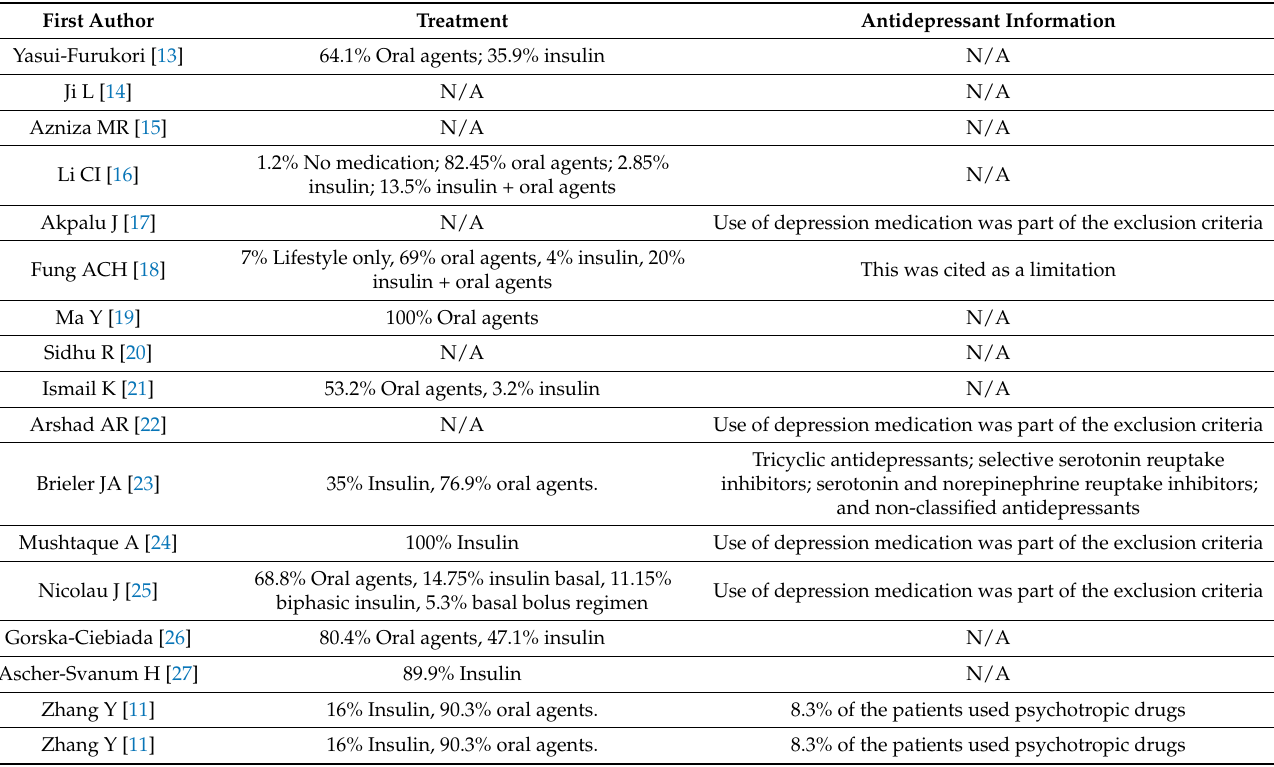
Table 3. Hypoglycemic and depression information of the patients